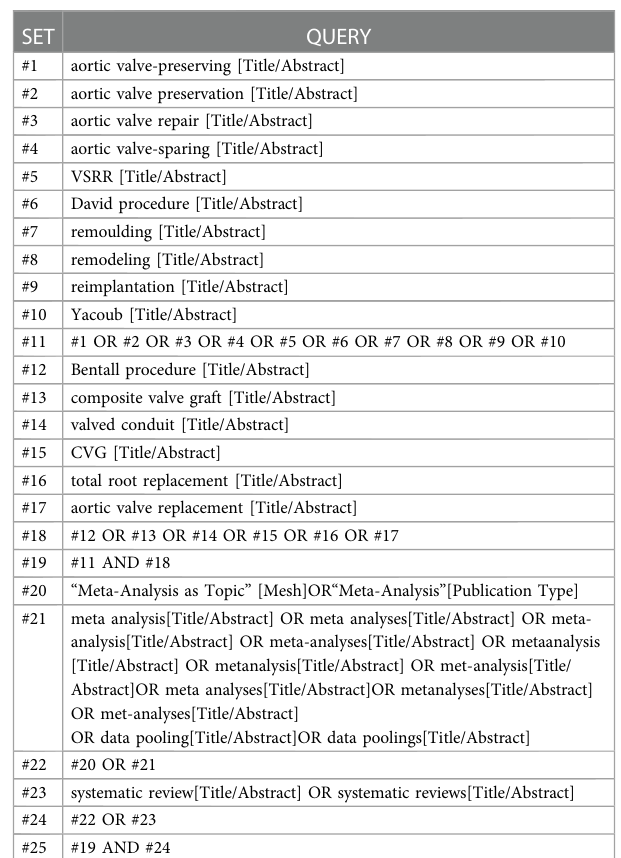
TABLE 1 The search strategy using pubmed as an